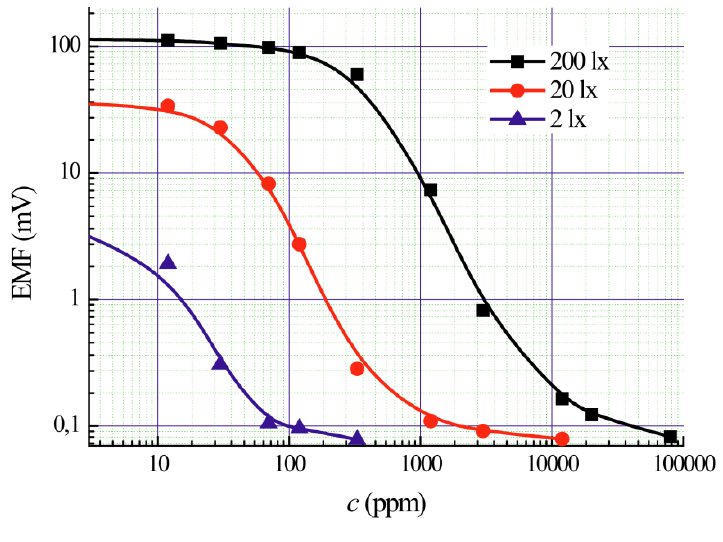
Figure 5. Dependences of Photo-EMF on ammonia concentration under different illumination